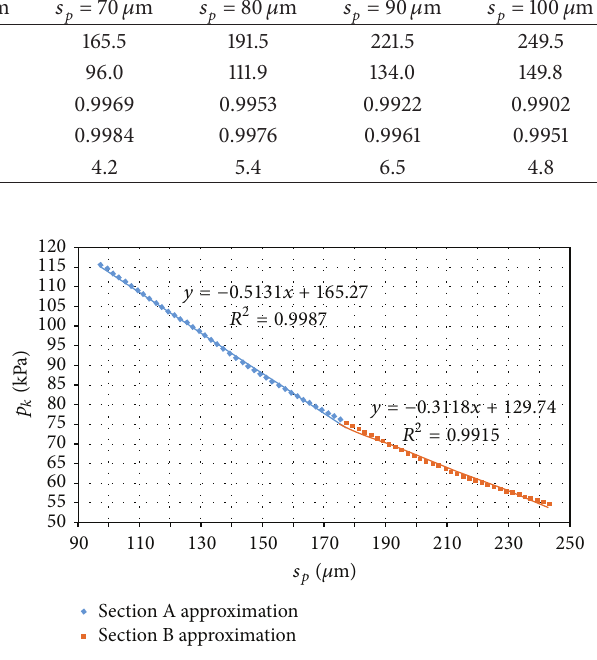
Figure 7: Example of the characteristics approximated with two